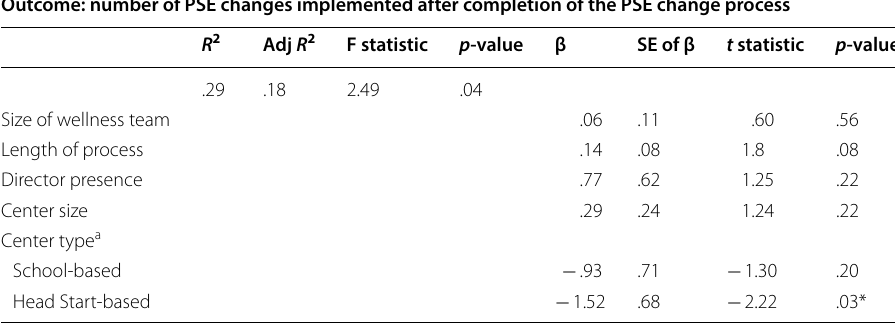
43 wellness teams) =